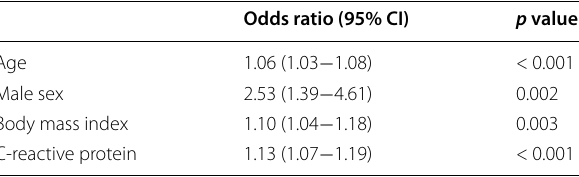
Table 5 Multivariate logistic regression model for worsening the respiratory